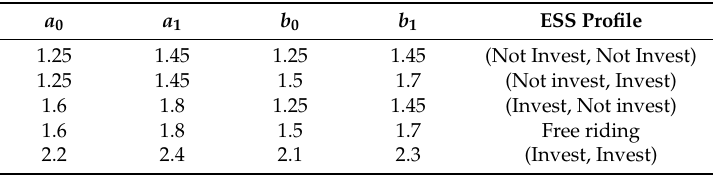
Table 6. Different Values of a 0 , a 1 , b 0 , and b 1